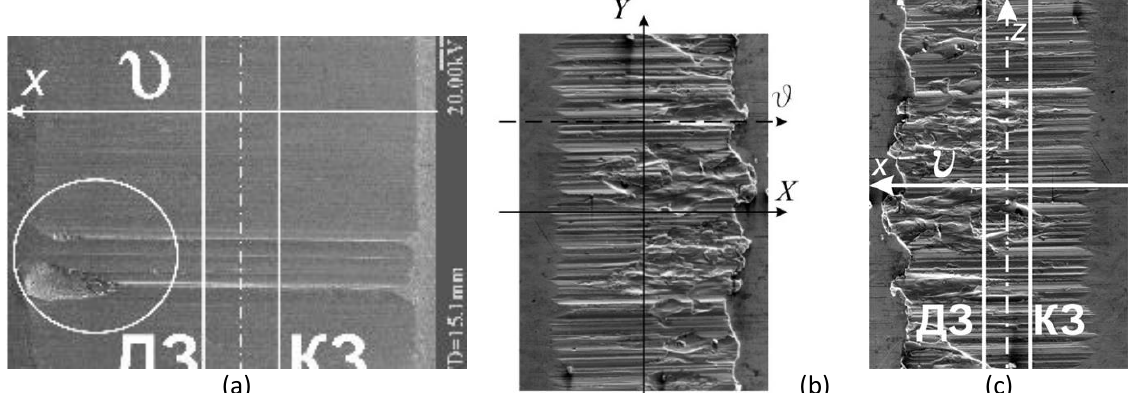
Fig. 3. Primary adhesion in the divergent area of contact with a characteristic pull-out of a fragment of the bearing material (a) and the regular appearance of friction tracks (wear traces): in the direction of friction: at the exit from the shaft contact (in the divergent elastically deformed area) - characteristic pull-outs of the material of a model plain bearing (b, c), and at the contact entry (in the convergent elastically deformed area) there are characteristic risks of deformation microcutting. Friction conditions: steel ШХ-15 with HRC=59~62, Ra<0.02mkm, initial, design, maximum contact stresses 2000MPa, linear velocity 0.3m/s, friction device ПТИ